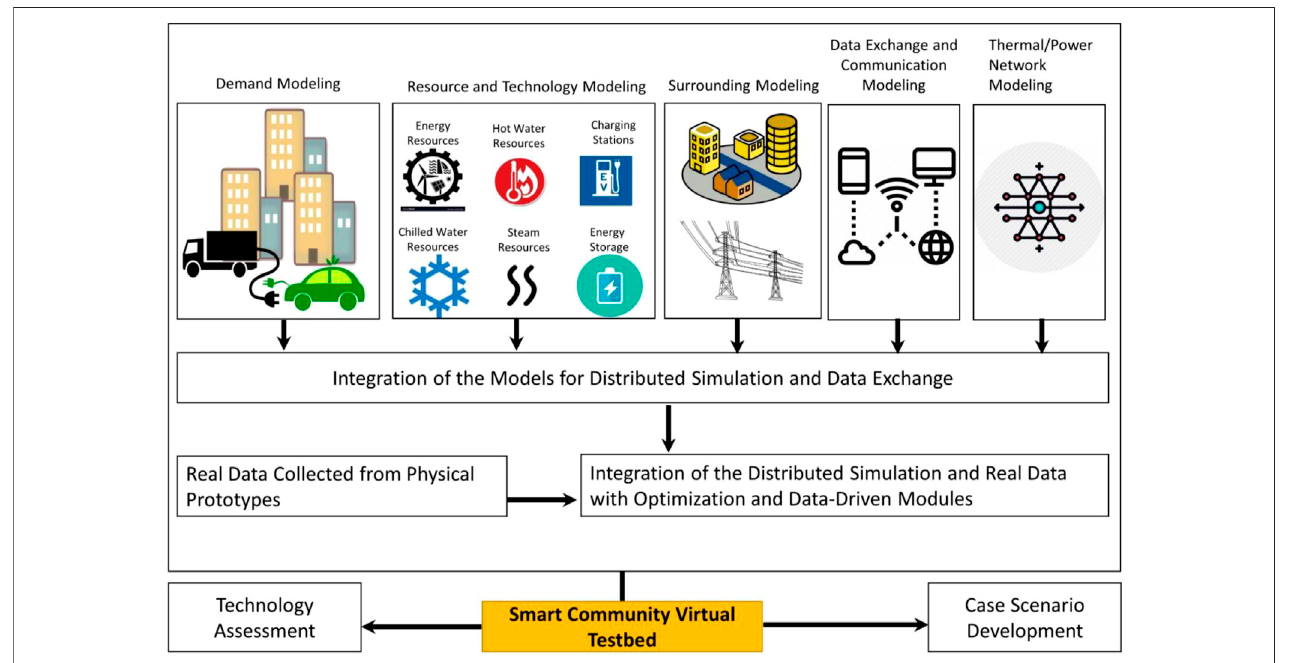
FIGURE 5 | Development of a virtual prototype to analyze the dynamics and behavior of a smart